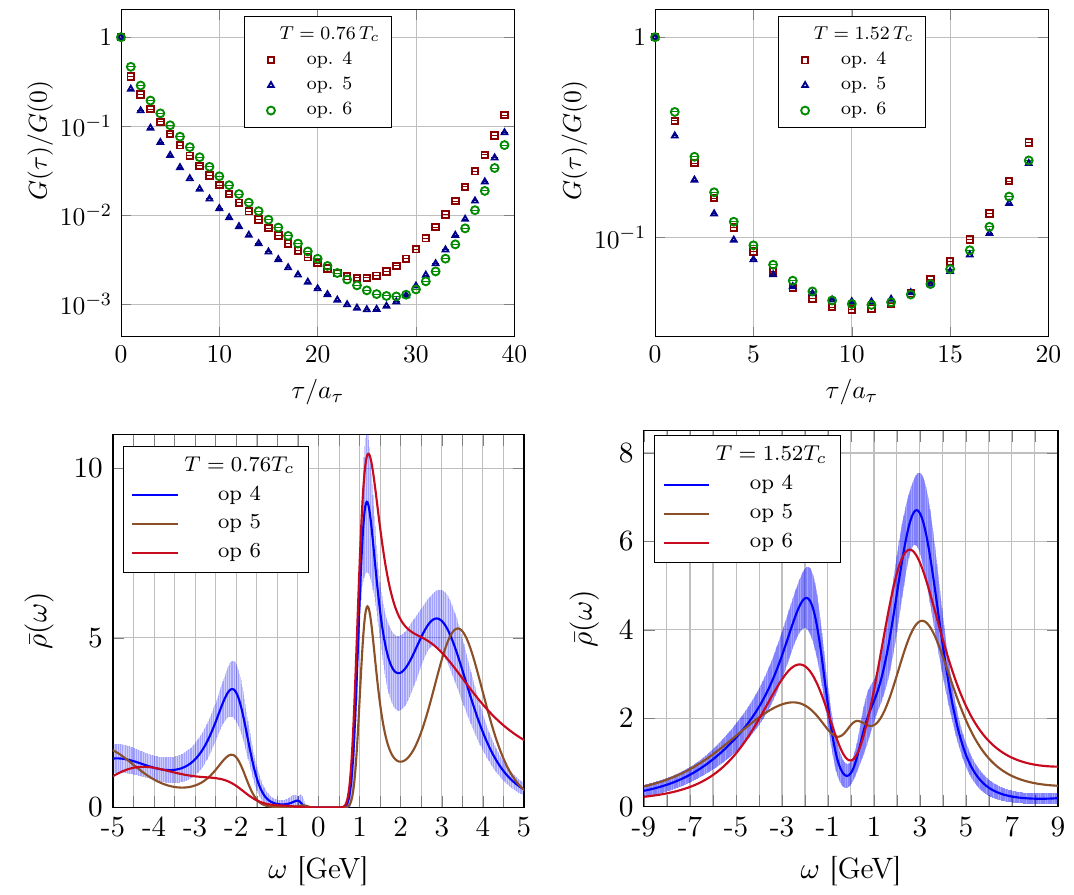
Figure 10 . Operator dependence in the nucleon channel at T=T c = 0 : 76 (left) and 1.52 (right), in the correlators (above) and the corresponding spectral functions (below). For clarity, error bands are shown for operator 4